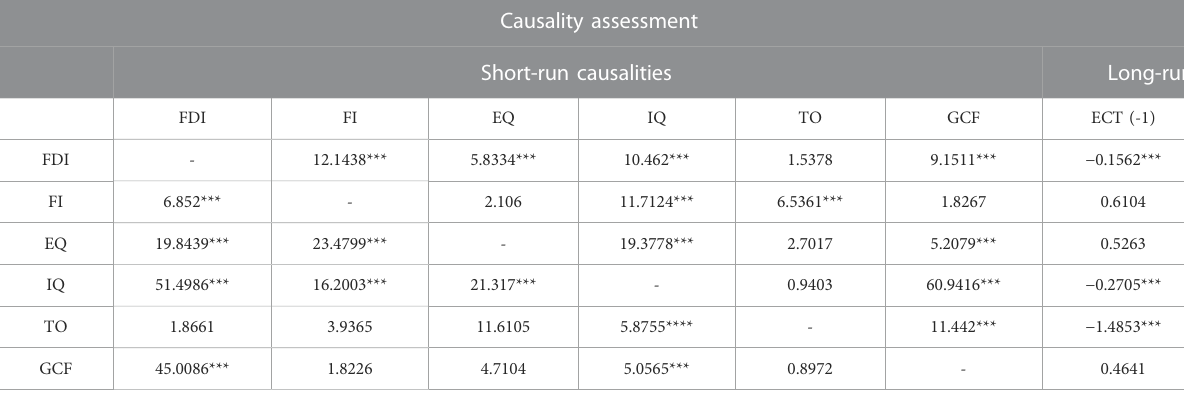
TABLE 9 Results of the panel Granger causality test under the error-correction